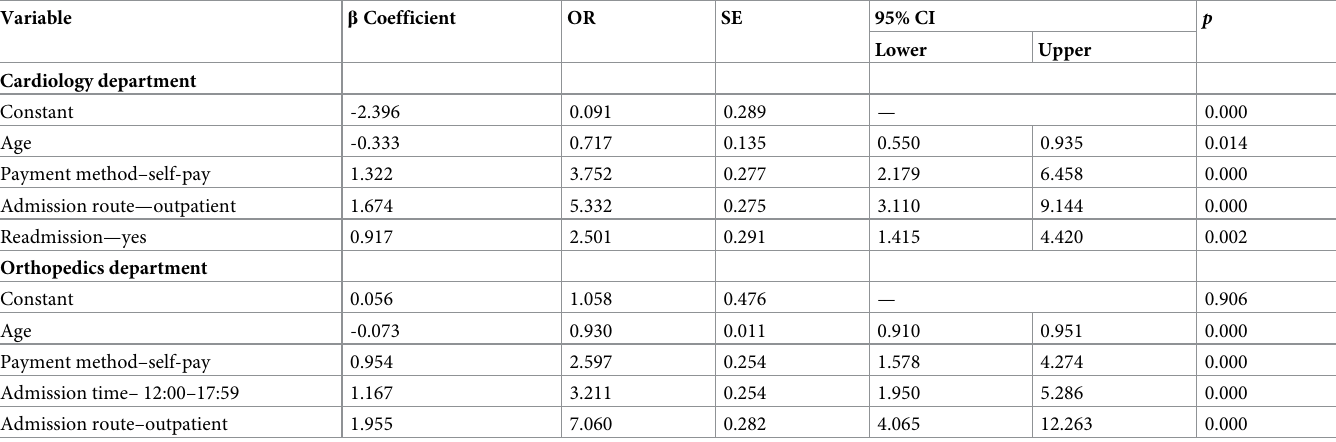
Table 3. Multivariate logistic regression analysis